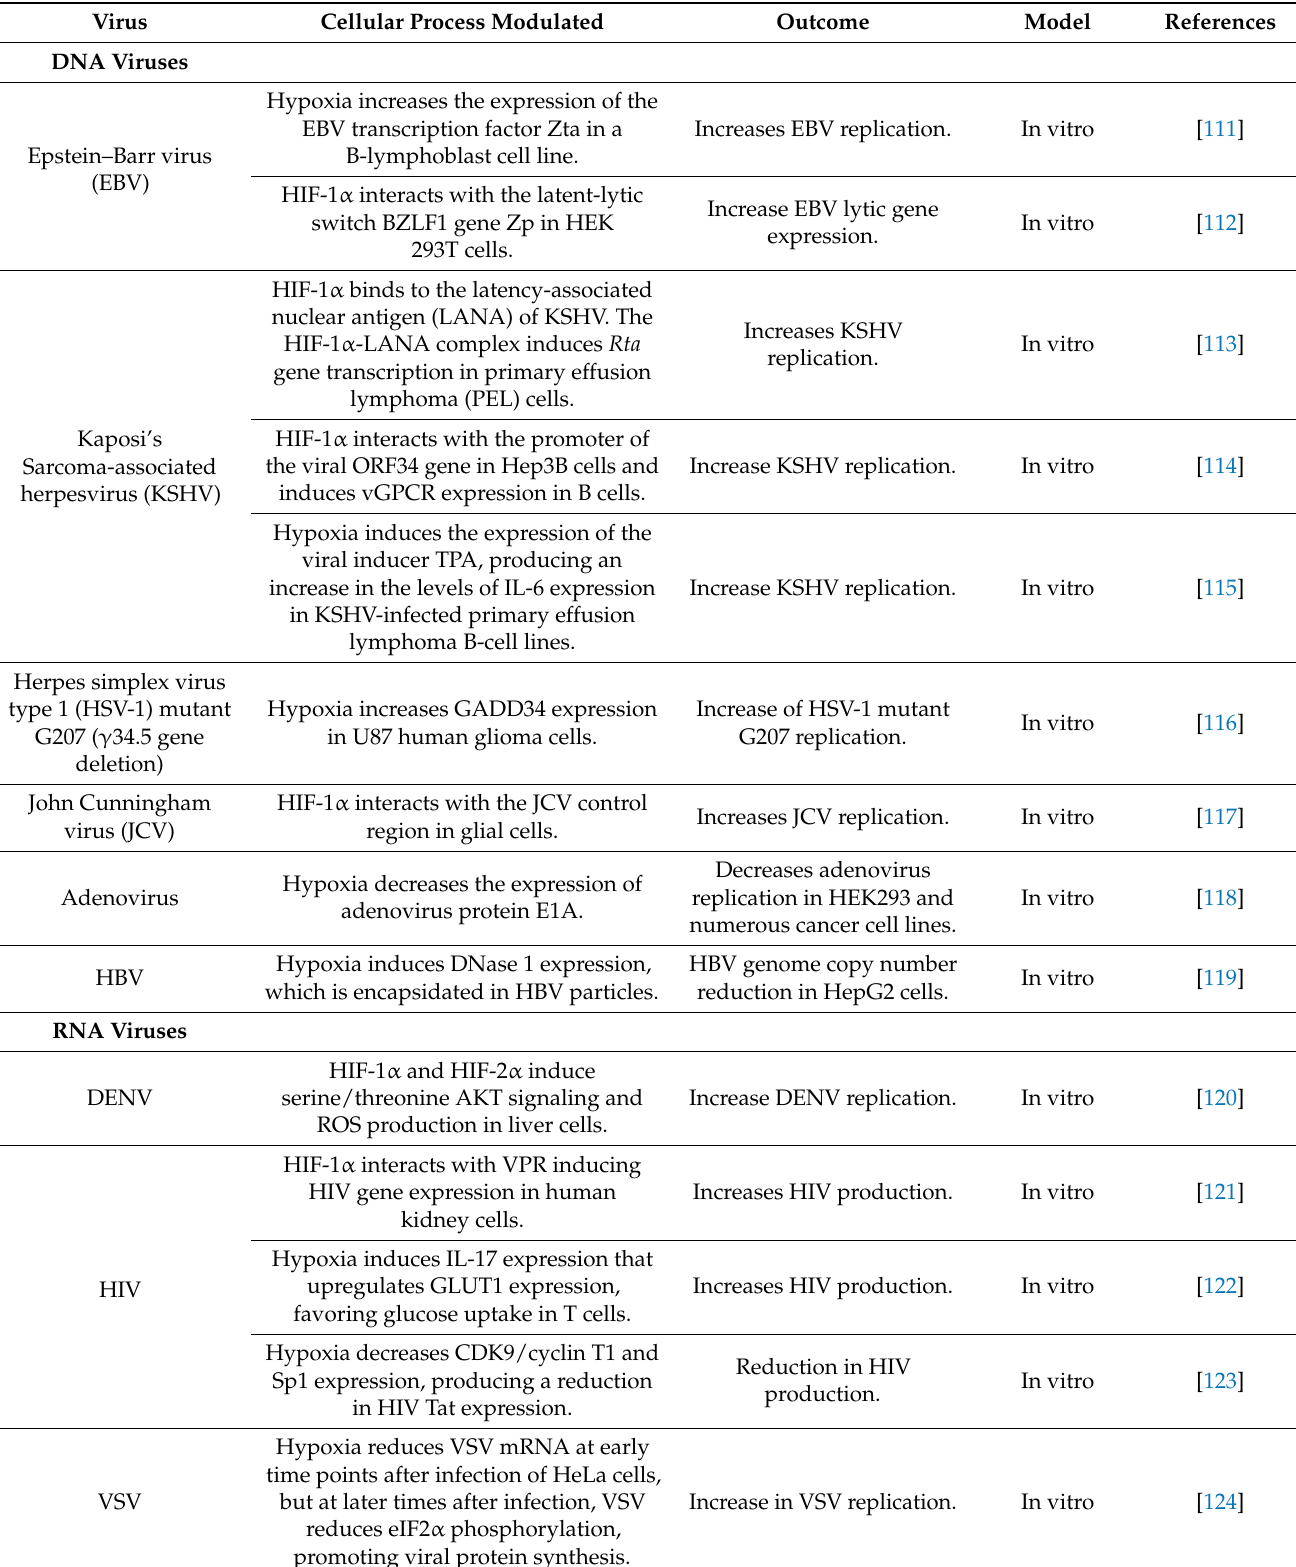
Table 1. Hypoxia effect over viral